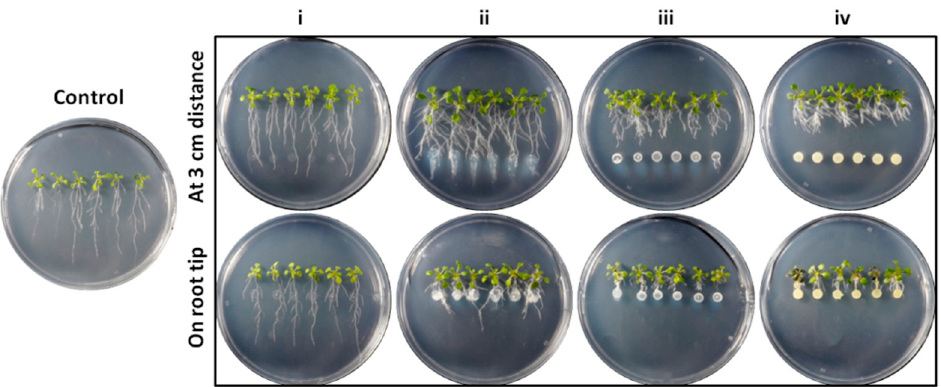
Figure 6. Co-cultivation of A. thaliana seedlings with endophytic bacterial strains inoculated on root tips and at 3 cm distance from root tips. Four morphological categories emerged after at-distance formulation: (i) plants with long PRL and decreased LRN, (ii) plants with long PRL and increased LRN, (iii) plants with intermediate PRL and increased LRN and (iv) plants with short PRL and increased LRN.